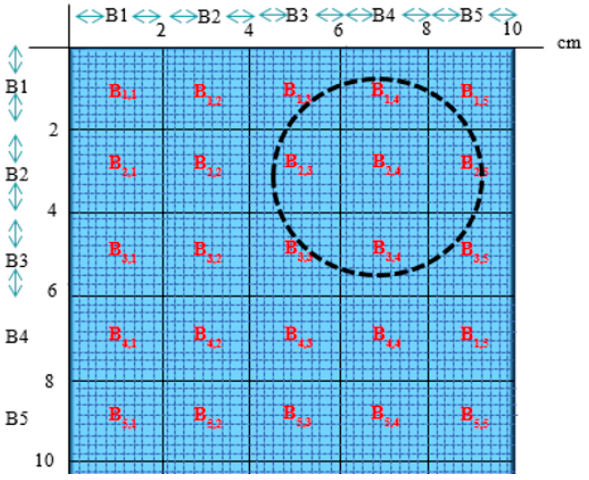
Figure 8. Schematic of the magnetic field strength measurement matrix in the sample area. Table 3. Table of the distribution of the magnetic field strength of the solenoid in the sample room. Rated Power (mT)